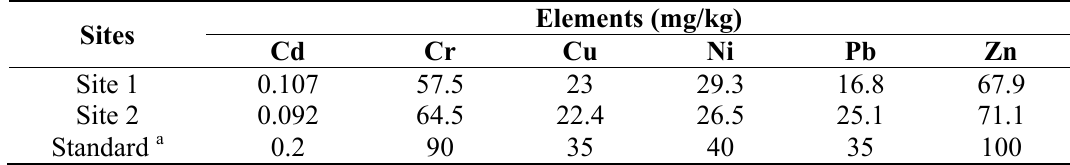
Table 3. Background values of heavy metal concentrations in the soils of the study areas. Sites